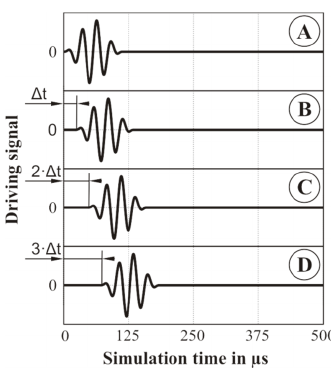
Figure 5. Transducer driving signals. ( A ) For the first transducer within the array. ( B ) For the second transducer within the array. ( C ) For the third transducer within the array. ( D ) For the fourth transducer within the array.